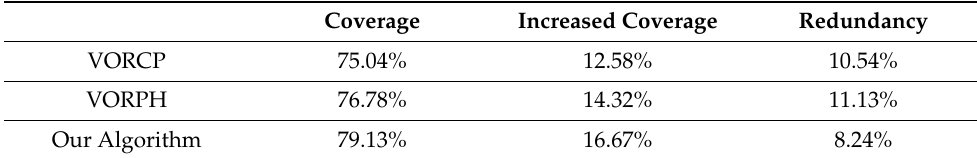
Figure 10. Nodes after VORPH patching. Table 1. Algorithm comparison.